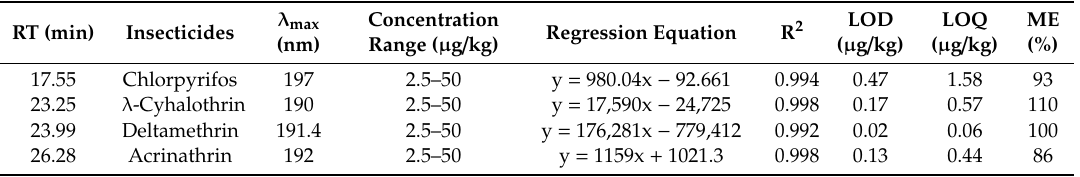
Table 2. Parameters of calibration, limit of detection (LOD), limit of quantification (LOQ) and matrix e ff ect (%) for insecticides using QuEChERS-dSPE / UHPLC-PDA